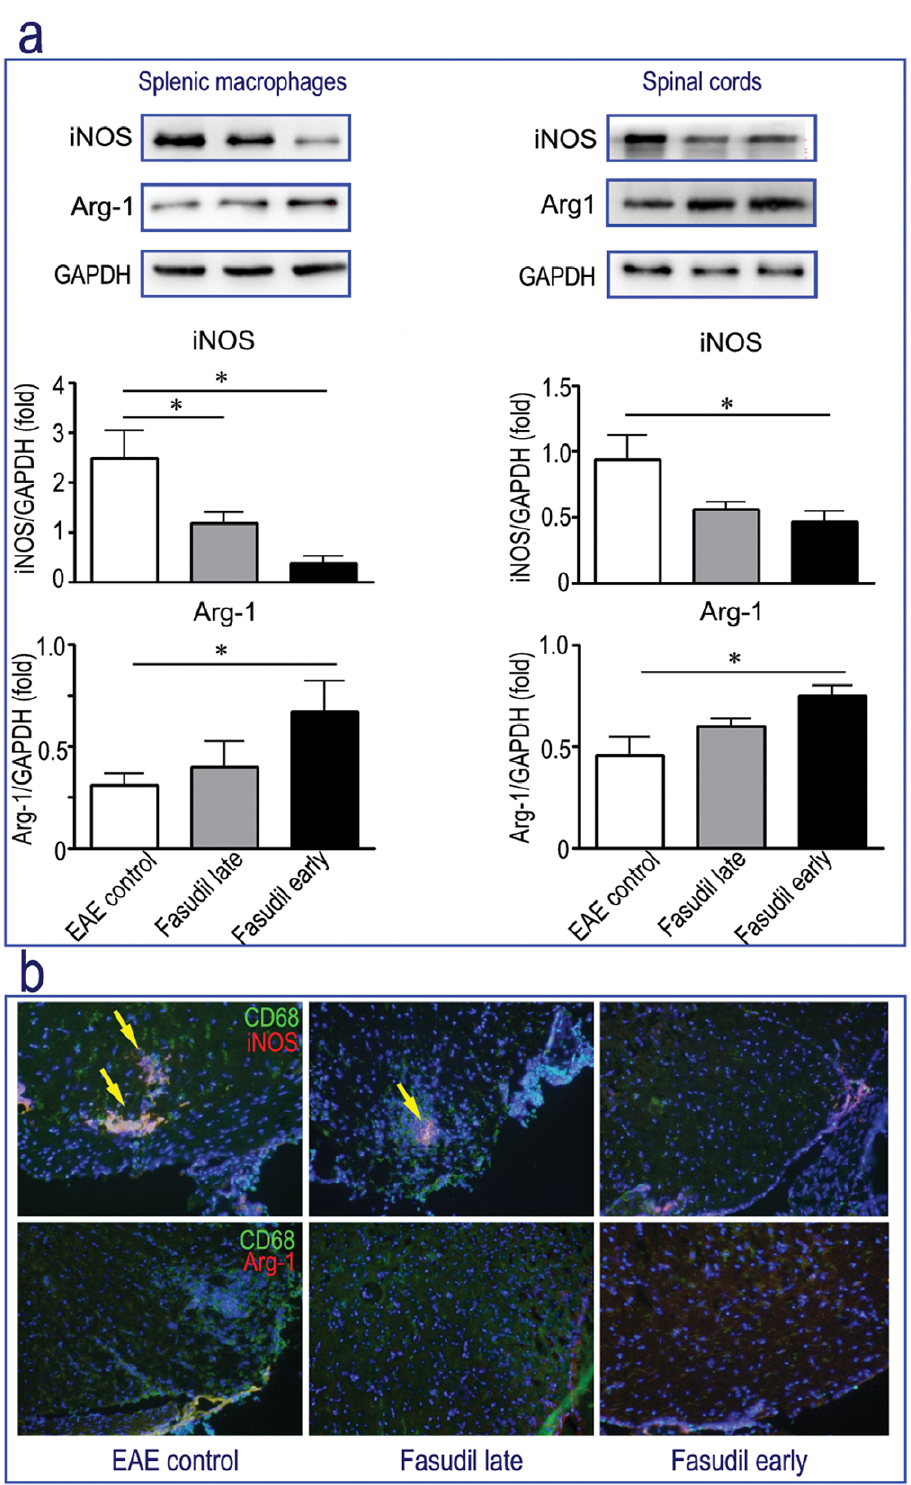
Figure 6. Fasudil enhances the ratio of Arg-1/iNOS. Chronic EAE was induced in C57BL/6 mice with MOG 35–55. Fasudil was injected (i.p.) at 40 mg/kg/d every other day on days 3 and 11 p.i. On day 21 p.i., mice were sacrificed, and protein was extracted from splenic macrophages and spinal cords. a) Representative bands of Western blot for iNOS and Arg-1 from one of two experiments with similar results. Quantitative analysis of iNOS and Arg-1 expression in splenic macrophages and spinal cords are analyzed for 4–5 mice in each group. Results are expressed as fold change relative to GAPDH as the loading control. * p , 0.05, ** p , 0.01, *** p , 0.001. b) The double staining of CD68 (green) and iNOS/Arg-1 (red) by immunohistochemistry. Representative patterns were obtained from one of three experiments with similar results.